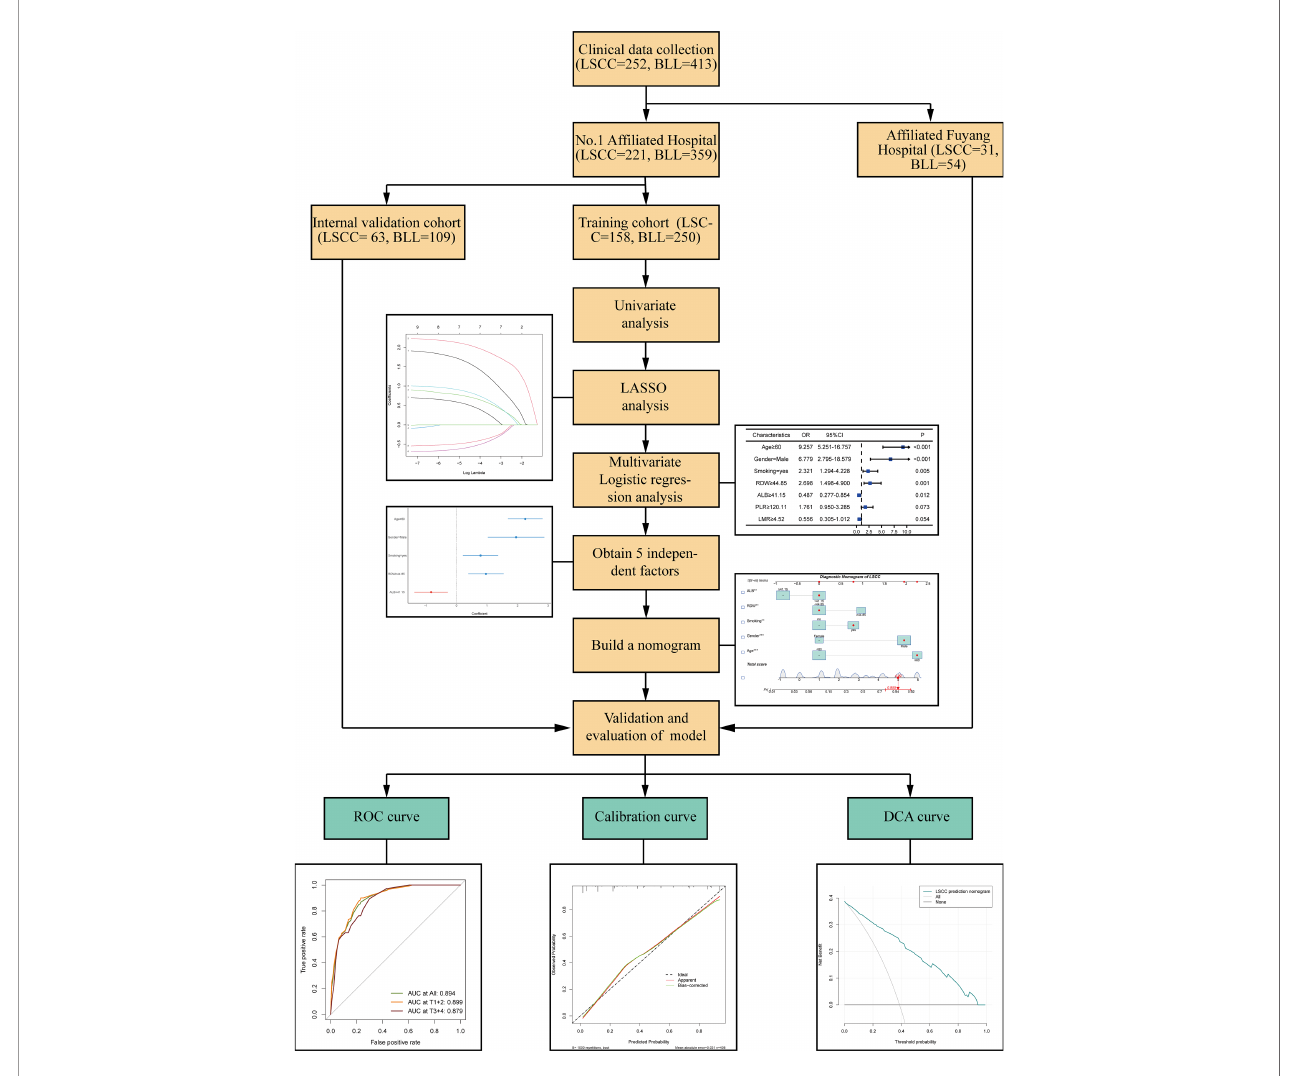
FIGURE 1 | Flow chart of the study process. ** p<0.01, ***